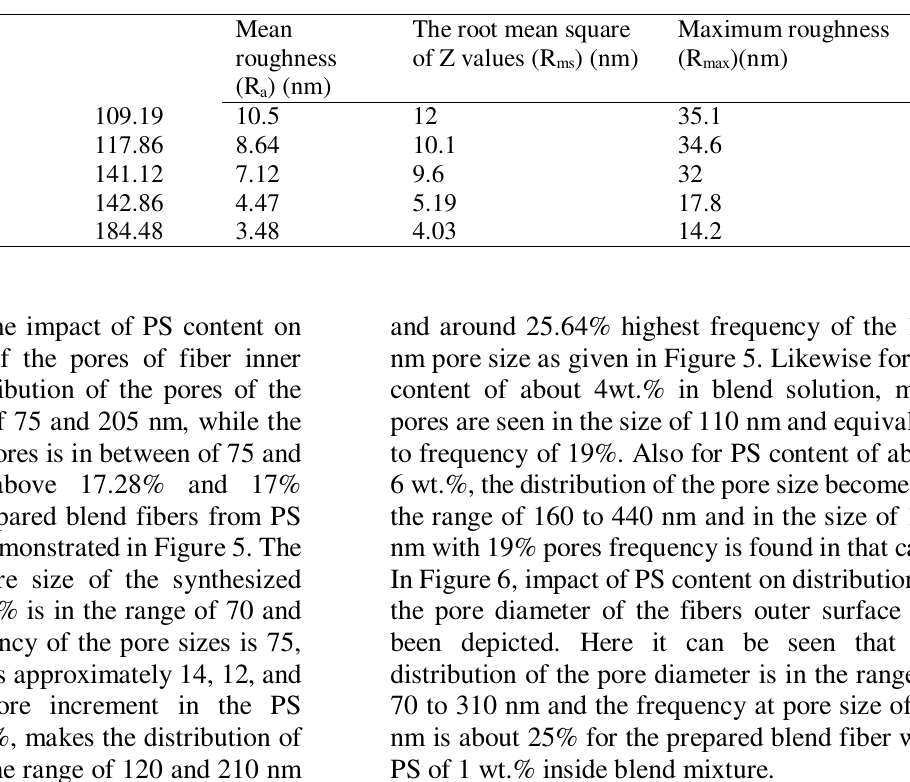
Table 2, Mean pore size and mean roughness of the outer surface of the hollow fiber blend membranes. Membrane